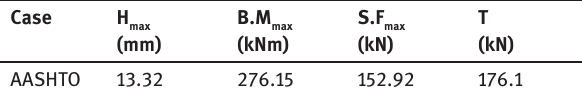
Table 7 Results of analysis with Indian codes